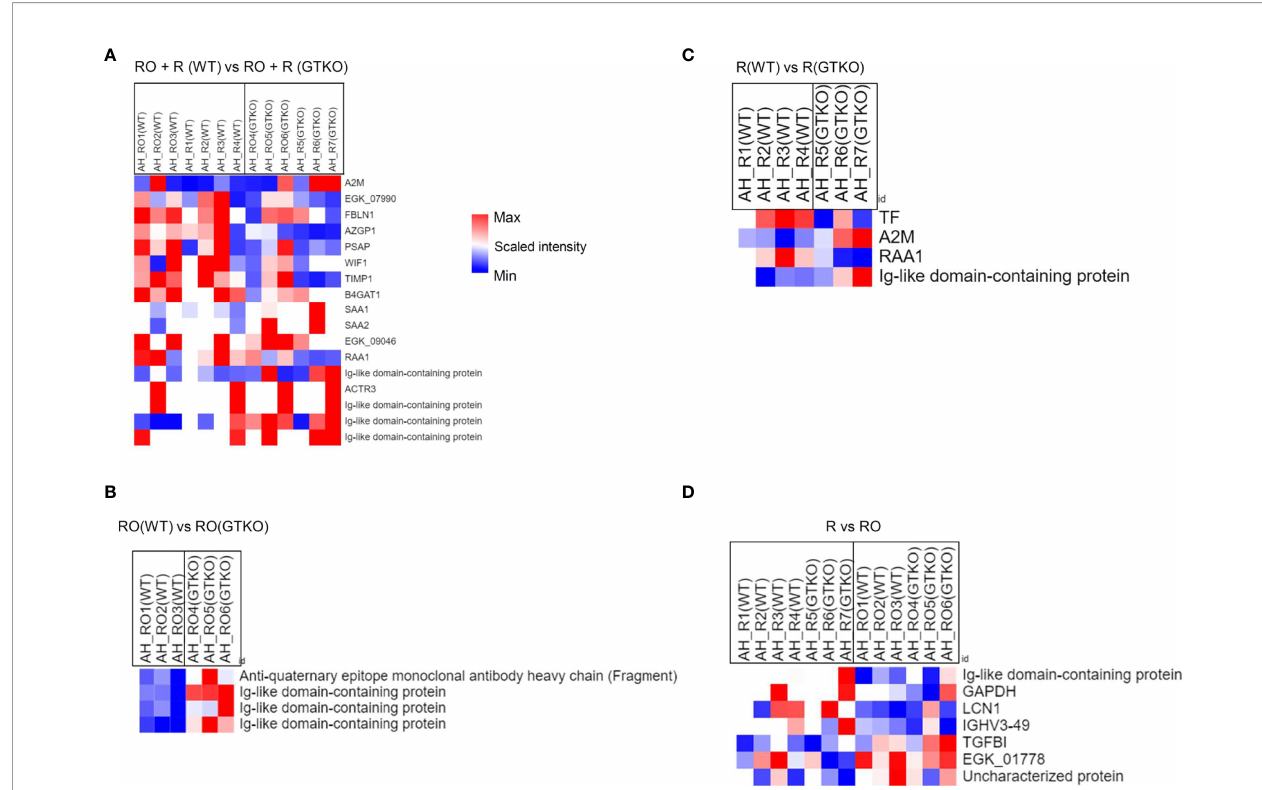
FIGURE 4 | Proteomic analysis of the subgroups in aqueous humor (AH) using a non-human primate ( Macaca mulatta ) library. (A) Cluster heat map of differentially expressed proteins (DEPs) comparing subgroups transplanted with wild-type (WT) or a -1,3 ‐ galactosyltransferase gene ‐ knockout (GTKO) porcine corneas when the rejection ongoing (RO) and rejection (R) groups were combined. (B) Cluster heat map of DEPs comparing subgroups transplanted with WT or GTKO porcine corneas in the RO group. (C) Cluster heat map of DEPs comparing subgroups transplanted with WT or GTKO porcine corneas in the R group. (D) Cluster heat map of DEPs comparing the R and RO groups regardless of donor corneal